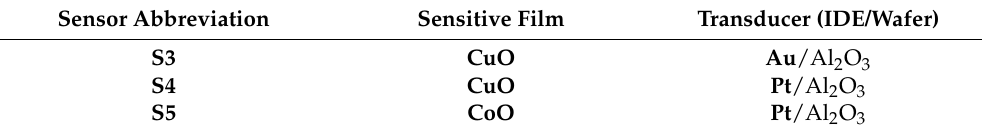
Table 1. The investigated sensors and their composition.